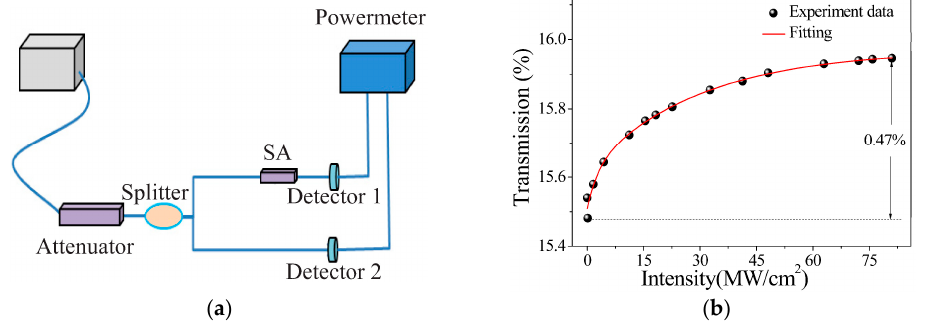
( d ) Figure 2. Characterization of BP nanosheets and BP–PI films. ( a ) Scanning electron microscope (SEM) image of the BP nanosheets. The inset is the photograph of the BP nanosheets dispersion; ( b ) atomic force microscopy (AFM) image of the BP nanosheets; ( c ) Raman spectrum of the BP sample; ( d ) sectional view of the BP–PI film. 3. Results and Discussion The saturable absorption property of the BP–PI film was measured by a balanced twin-detector technique, as described in Figure 3a. The illumination pulse was generated from a passively mode-